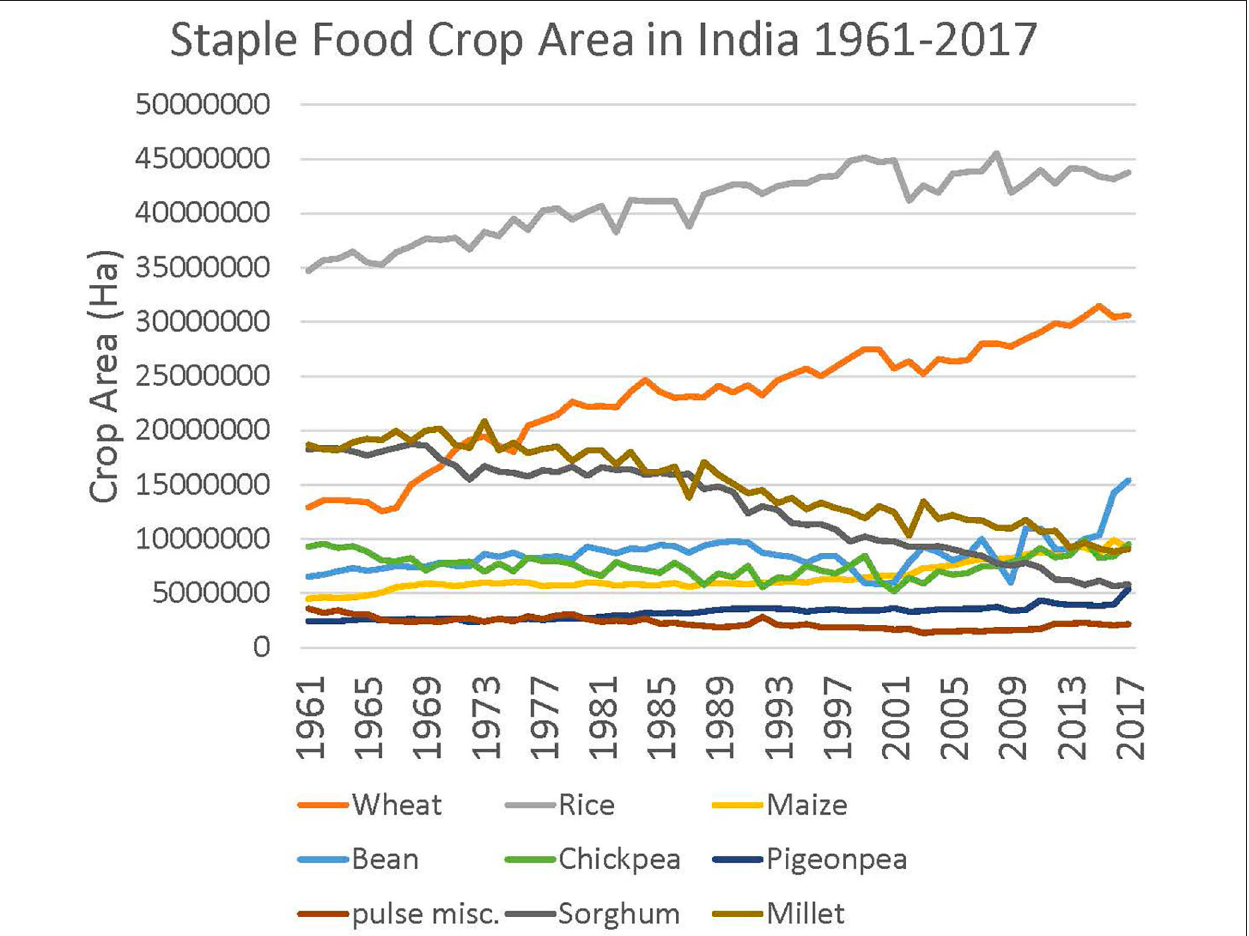
FIGURE 1 | India production area associated with nine major food crop categories (FAOSTAT,